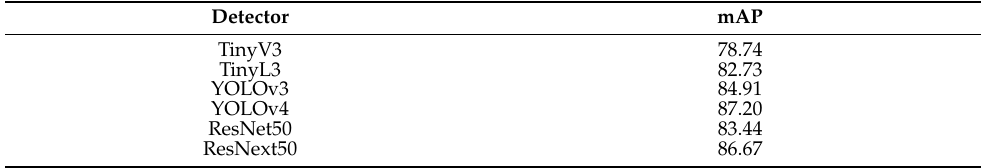
Table 5. Retrained results with confidence